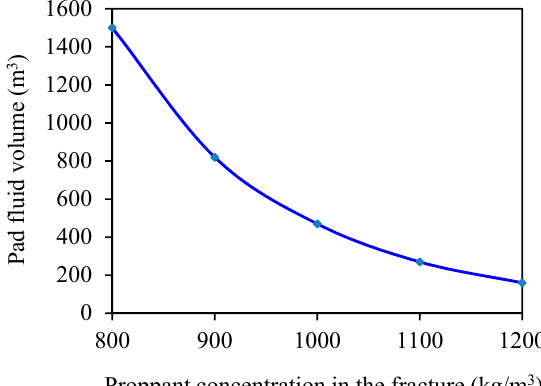
Figure 18. Optimal pad fluid volume vs. desired proppant concentration.